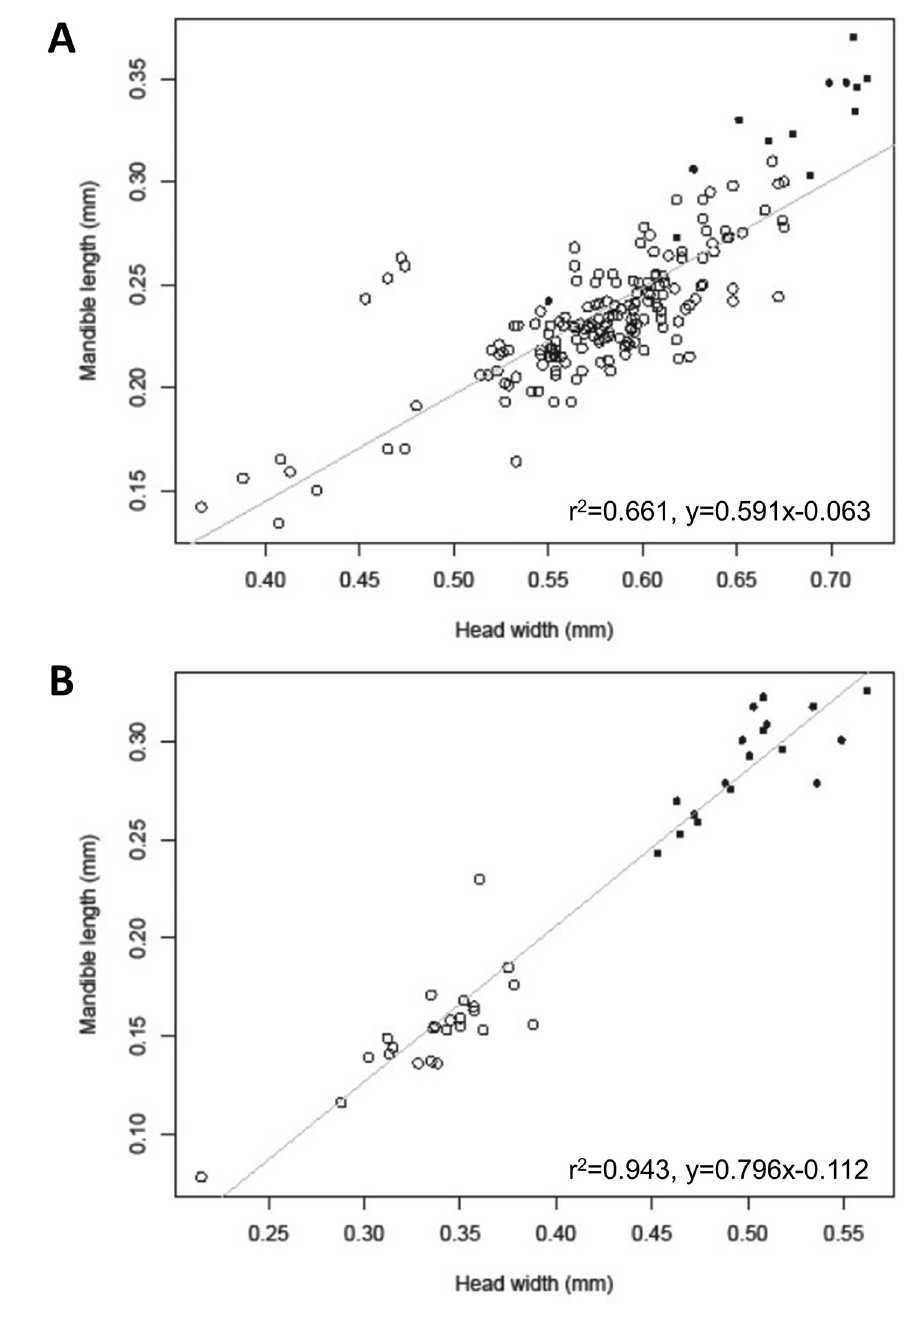
Figure 2. Relationship between head width and mandible length in a Philotrypesis and b Sycorycteridea . Typical Philotrypesis and small Sycorycteridea are represented by the unfilled circles whereas atypical Philot- rypesis and large Sycorycteridea are represented by filled